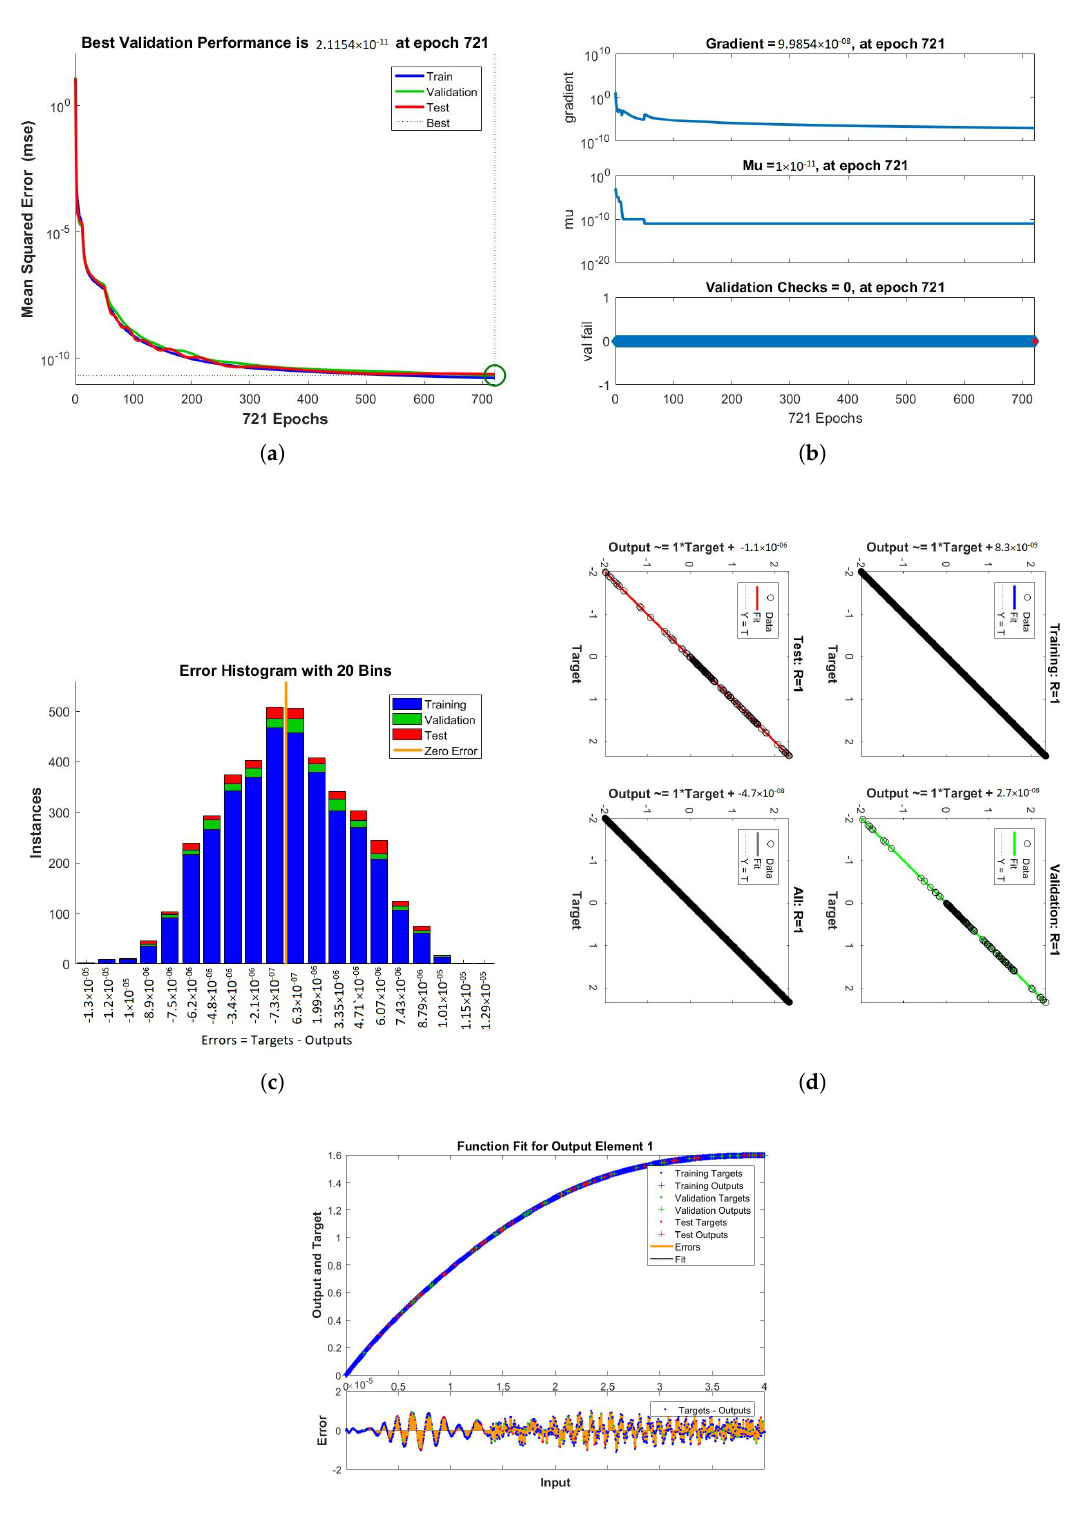
Figure 16. Figures showing the performance, training, error histogram, regression, and fitness graphs of the LMB-NN when value of the volume fraction φ = 0.1. ( a ) Performance. ( b ) Training. ( c ) Error Histogram. ( d ) Regression. ( e )